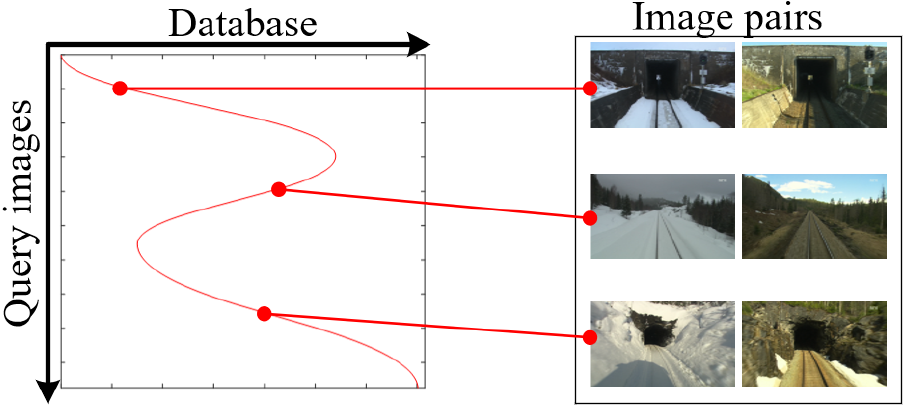
Figure 6. Ground truth of the corresponding frames and examples of matched frames.